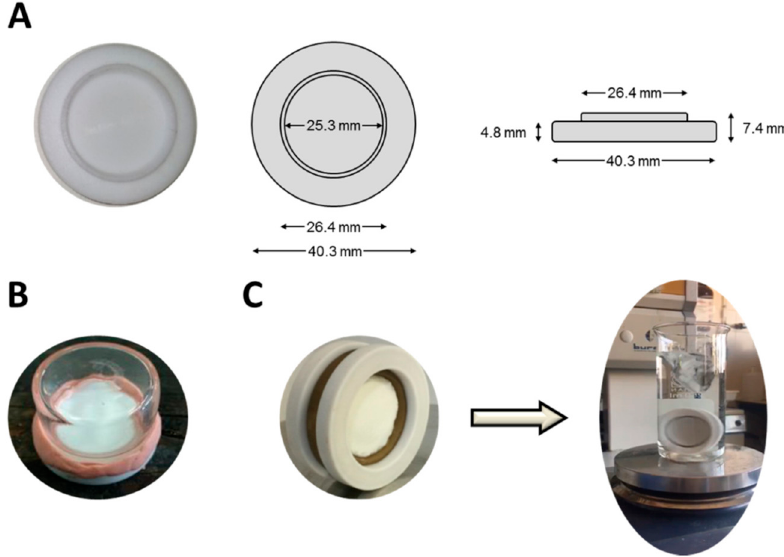
Figure 11. ( A ) Scheme and dimensions of the employed polytetrafluoroethylene (PTFE) disks; ( B ) polymerization assembling; ( C ) sampling assembling. Reprinted from [46], with permission from Elsevier, 2019.